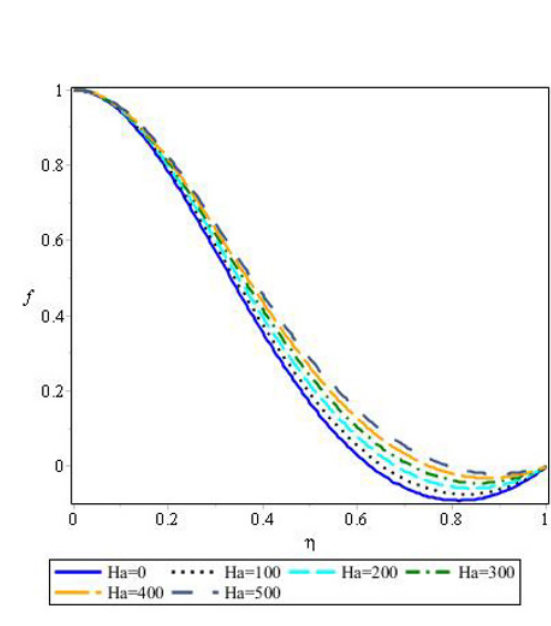
Figure 18. f ( η ) for different values of Re ( A ∗ = 1 , Ha = 0 , α = 1 ◦ , φ = 0 ).